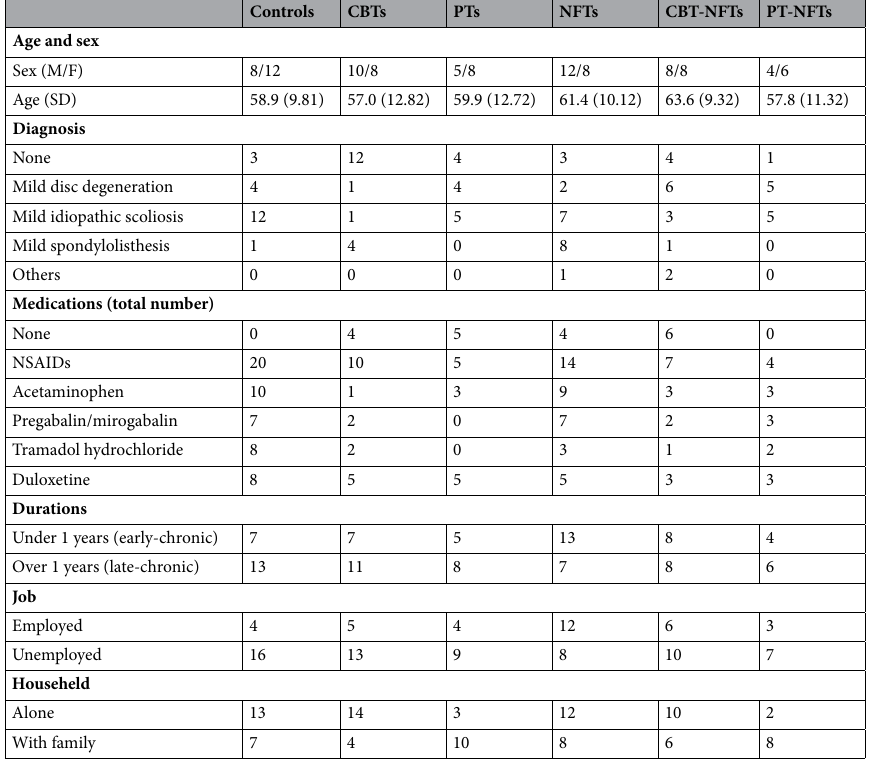
Table 1. Demographic characteristics of study